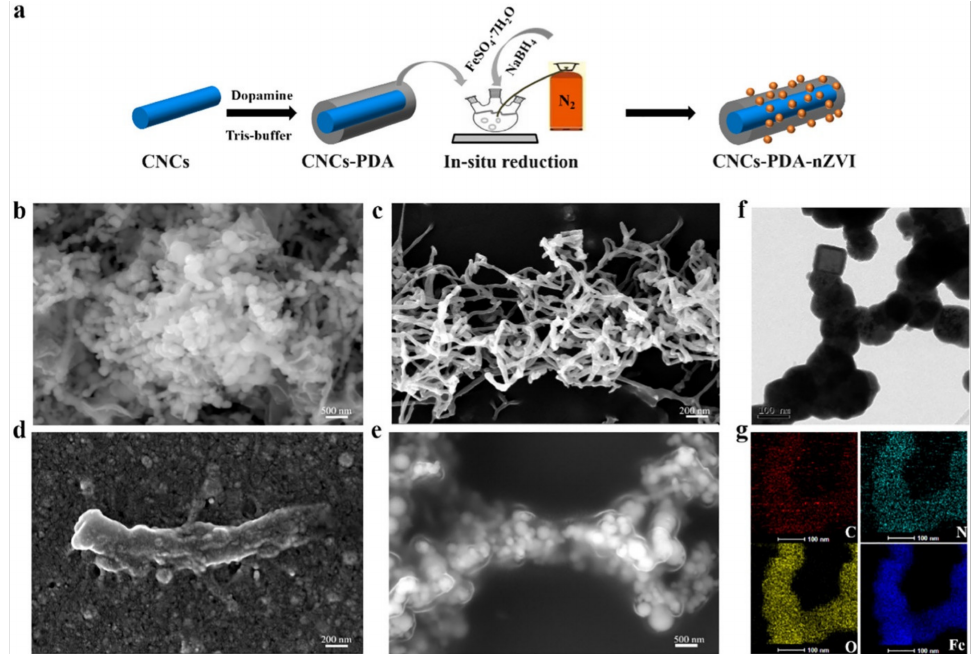
Figure 8. ( a ) Schematic representation of the fabrication of the CNCs–PDA–nZVI and SEM images of: ( b ) nZVI, ( c ) CNCs, ( d ) CNCs–PDA, ( e ) CNCs–PDA–nZVI, ( f ) TEM image of CNCs–PDA–nZVI,